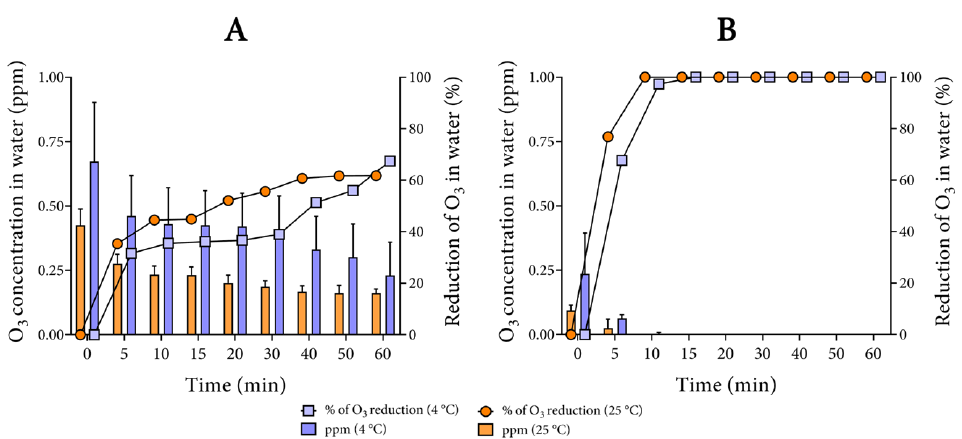
Figure 3. Sixty-minute ozone stability in tap water. Ozonation of non-buffered ( A ) and buffered ( B ) tap water. The left y-axis is fitted the mean with standard deviation for the concentration in parts per million (ppm). The right y-axis is fitted the percentage of the O 3 reduction in water. Both displayed y-axes were obtained from the same experiment. The percentage of O 3 reduction in water was calculated considering the first sample (0 min) as the basis. Adjustments of the pH and buffering were performed with 1 M HCl and 20 mM PB, respectively.